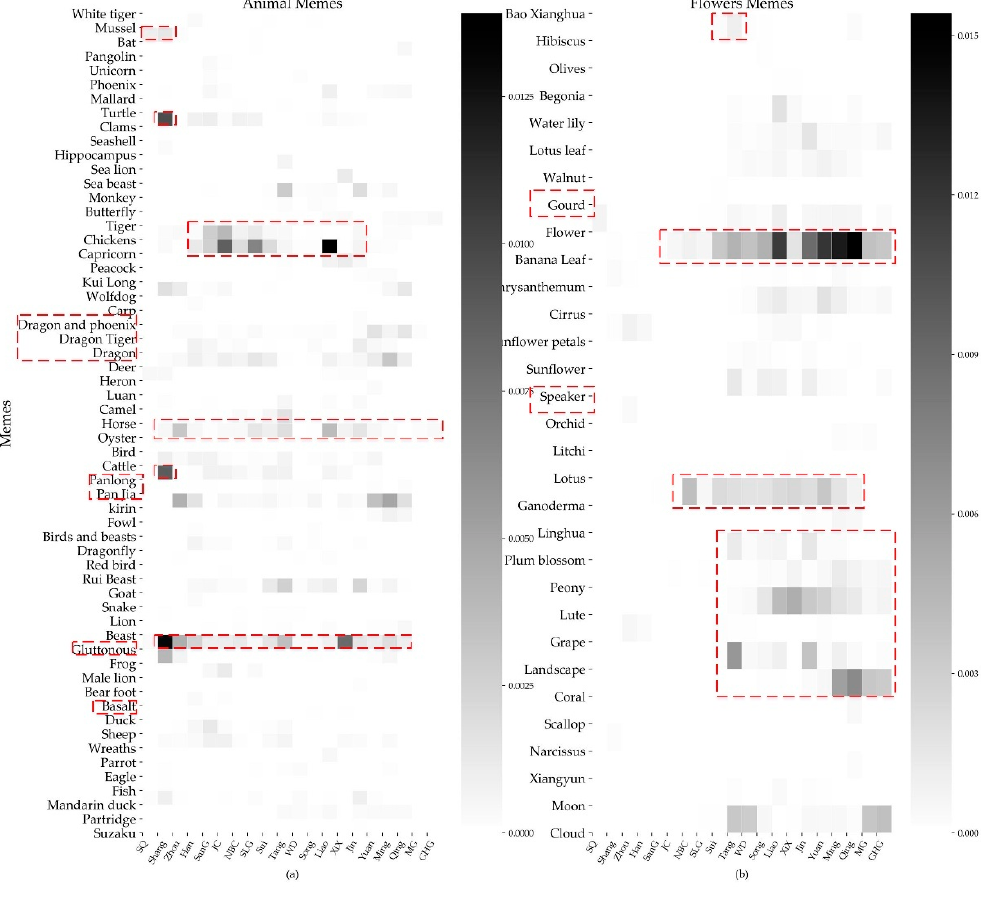
Figure 4. Distribution trend of auxiliary memes. ( a ) Illustrates the meme related to animals, while ( b ) is about floristic memes.